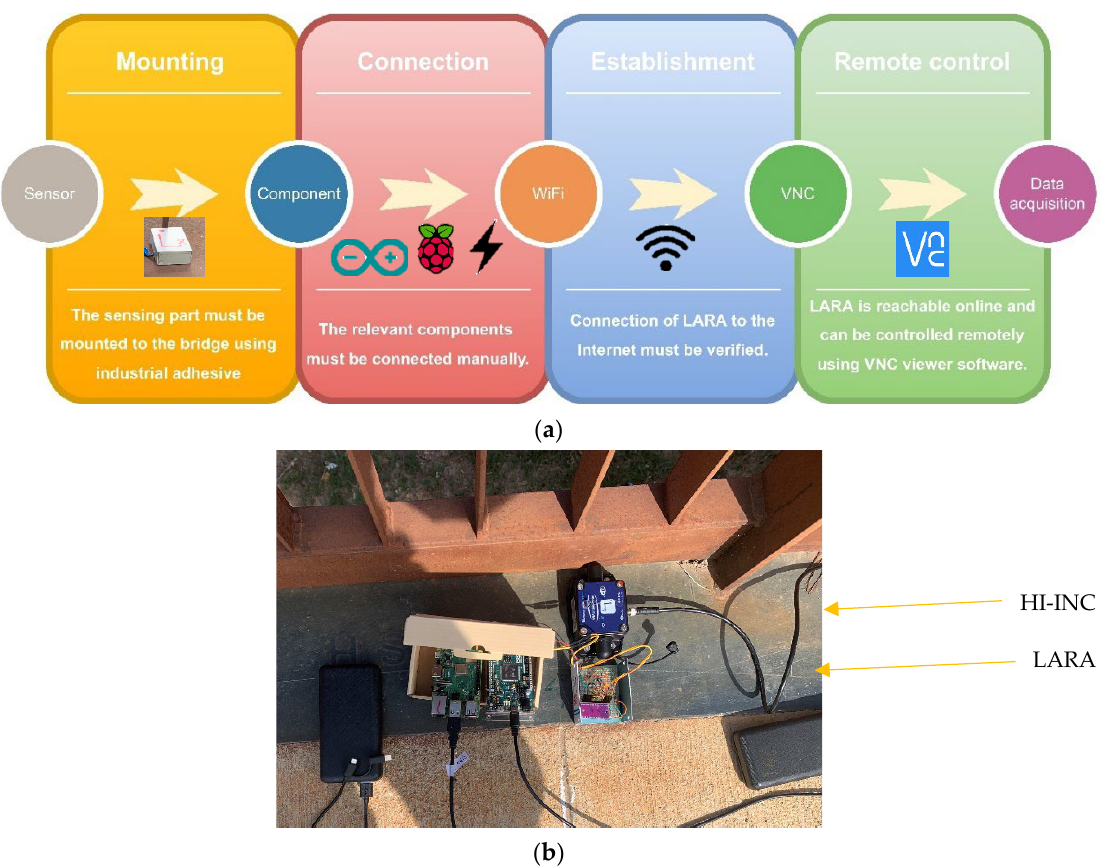
Figure 11. Mounting the sensors to the mid span of the bridge under study: ( a ) mounting diagram of LARA to the bridge and ( b ) photo of LARA and HI-INC sensor mounted on a footbridge in Barcelona.